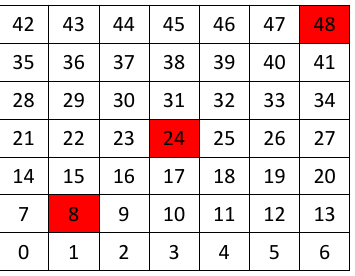
Figure 1. Network